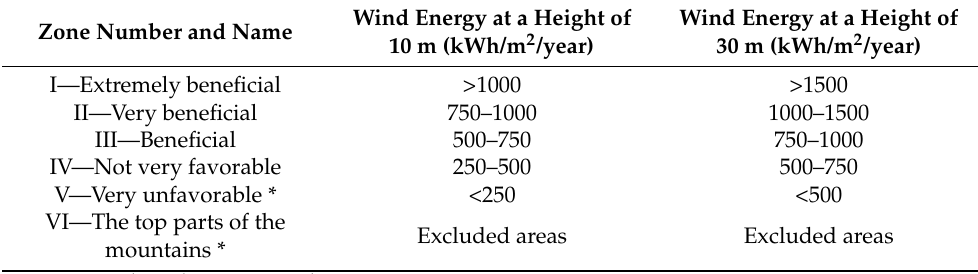
Table 11. Description of wind energy zones given on the map (Figure